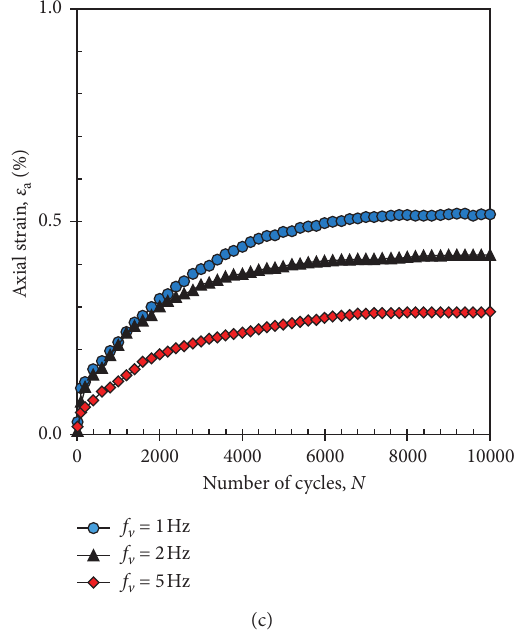
Figure 13: Variation of ε a with N at f c of (a) 1Hz, (b) 2Hz, and (c) 5Hz.